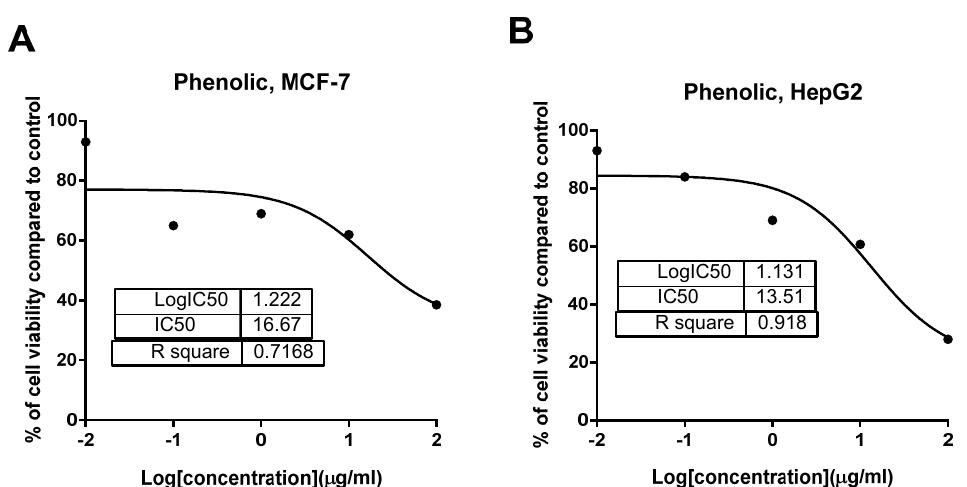
Figure 2. Dose–response nonlinear regression curve fitting the percentage of cell viability vs. log [con. µg/mL], R square ≈ 1, using the GraphPad prism software. ( A ) Cytotoxicity of phenolic extract against MCF-7; ( B ) cytotoxicity of phenolic extract against HepG2 cell line.